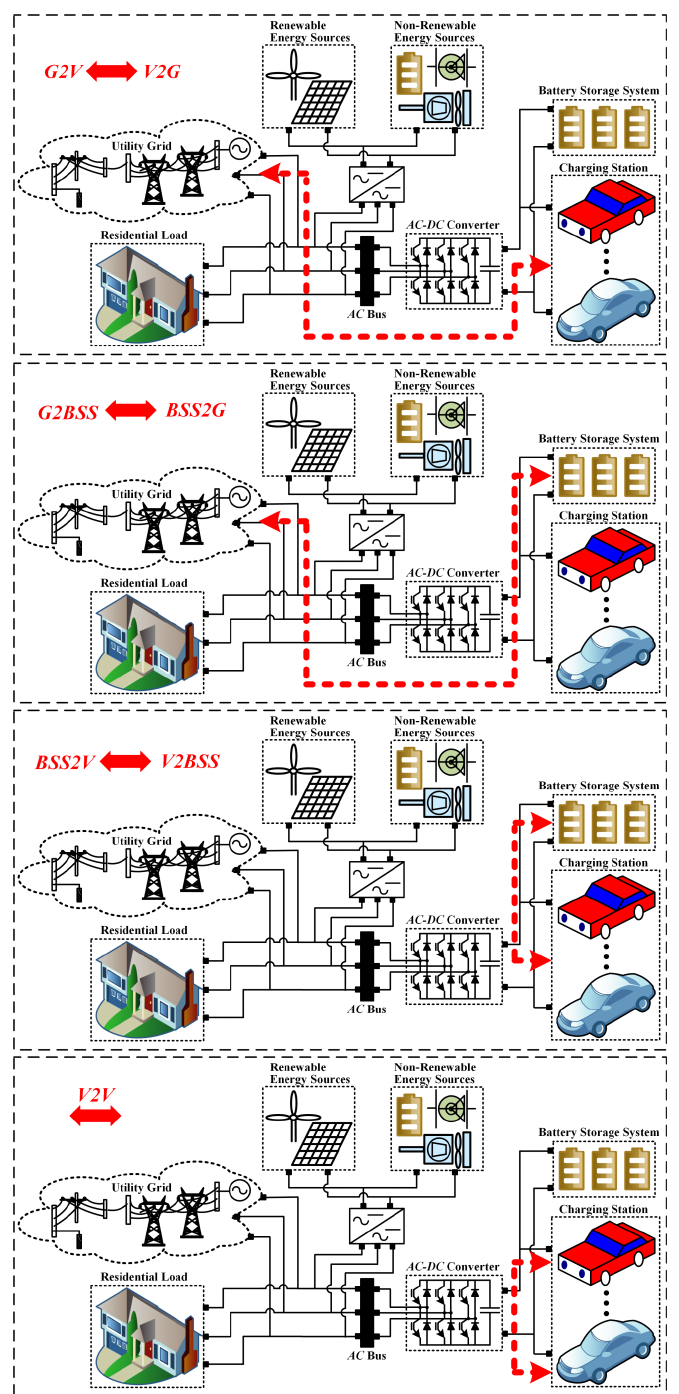
Figure 3. Modes of